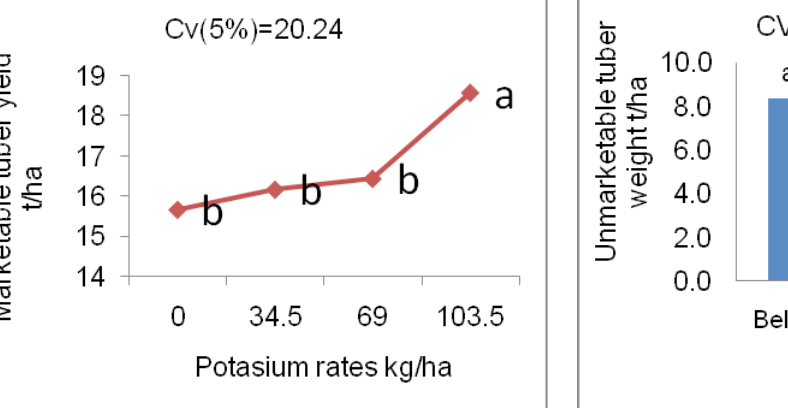
Figure 3: Marketable yield results of 0 to 103.5kg/ha potassium rates. The 1 st , 2 nd , 3 rd and 4 th stars indicated the 0, 34.5, 69 and 103.5kg/ha potassium rate results of marketable yield ton/ha, respectively